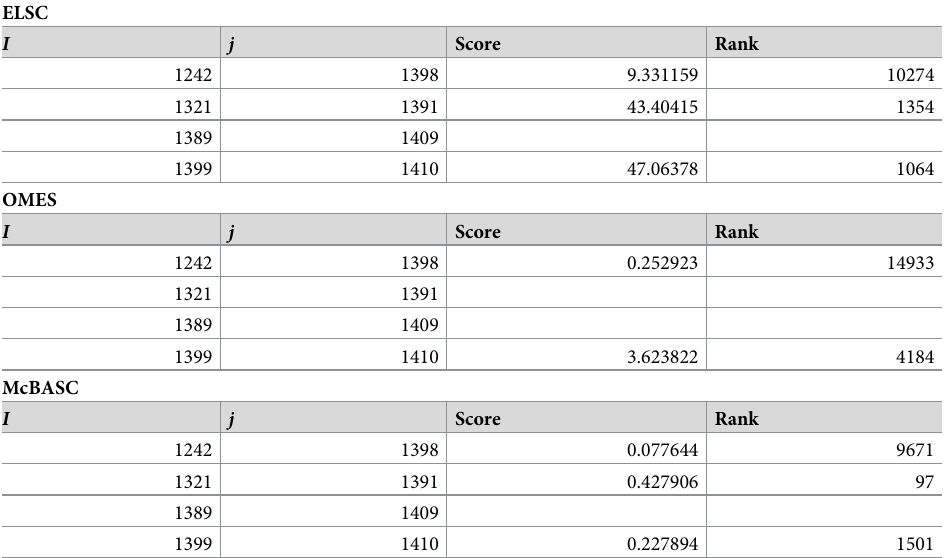
Table 5. 1251 Subset coupled residues in agreement with Gulya´s-Kov à cs study[19].